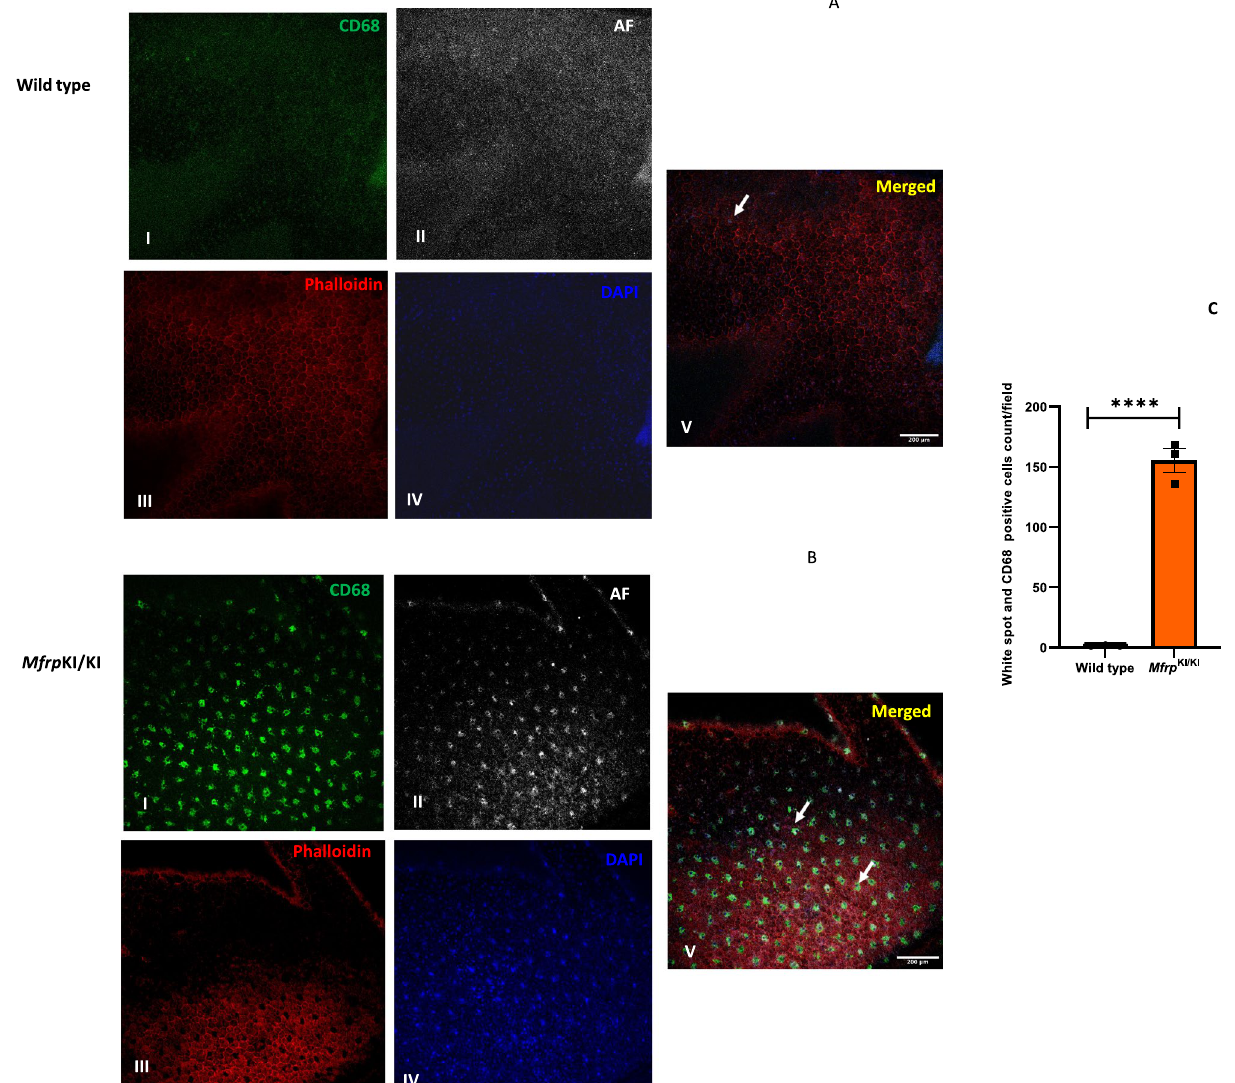
Figure 4. Confirmation of the microglial origin of autofluorescent spots in Mfrp KI/KI mice retina. ( A,B ) Retinal wholemount immunostaining for CD68 positive cells and autofluorescent spots using confocal microscopy with × 20 lens (Right panel), enlarged view of individual spots (I-CD68, II-AF (Autofluorescence), III- phalloidin (for actin, staining) IV-DAPI, V-Merged), (Left panel) show that ( C ) a significantly higher number of autofluorescent spots were present in Mfrp KI/KI mice retina (**** p < 0.0001) (n =